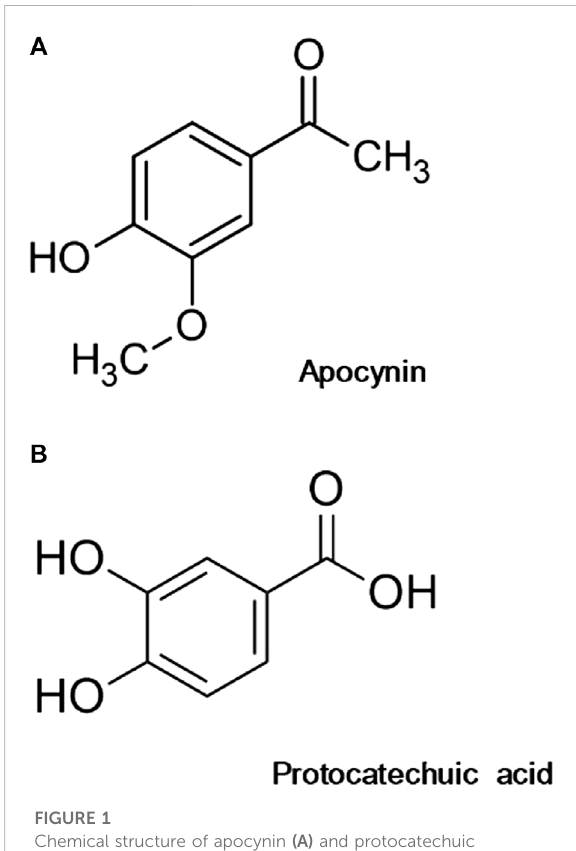
FIGURE 1 Chemical structure of apocynin (A) and protocatechuic acid (B)